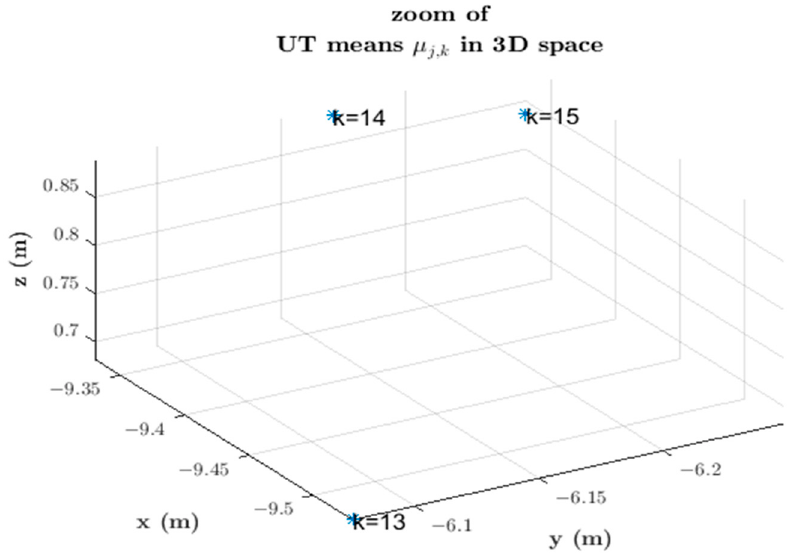
Figure 15. Final 3D means µ fk at instants k = 13, k = 14, and k = 15 after averaging their respective Figure 15. Final 3D means 𝜇 (cid:3033)(cid:3038) at instants k = 13, k = 14, and k = 15 after averaging their respective Figure 15. Final 3D means 𝜇 (cid:3033)(cid:3038) at instants k = 13, k = 14, and k = 15 after averaging their respective simultaneous UT means µ jk seen in Figure simultaneous UT means 𝜇 (cid:3037)(cid:3038) seen in Figure 14. simultaneous UT means 𝜇 (cid:3037)(cid:3038) seen in Figure 14.